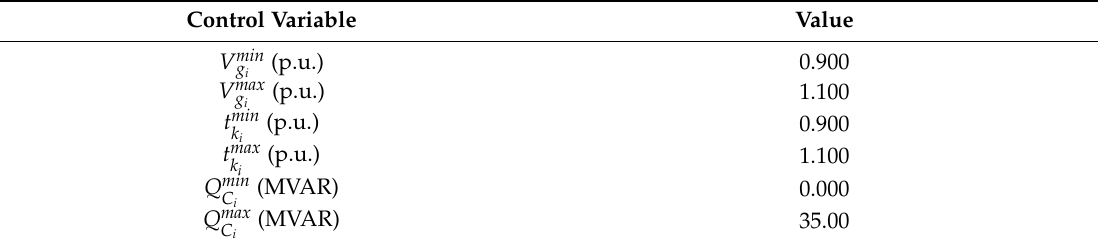
Table 3. Control variables limits.